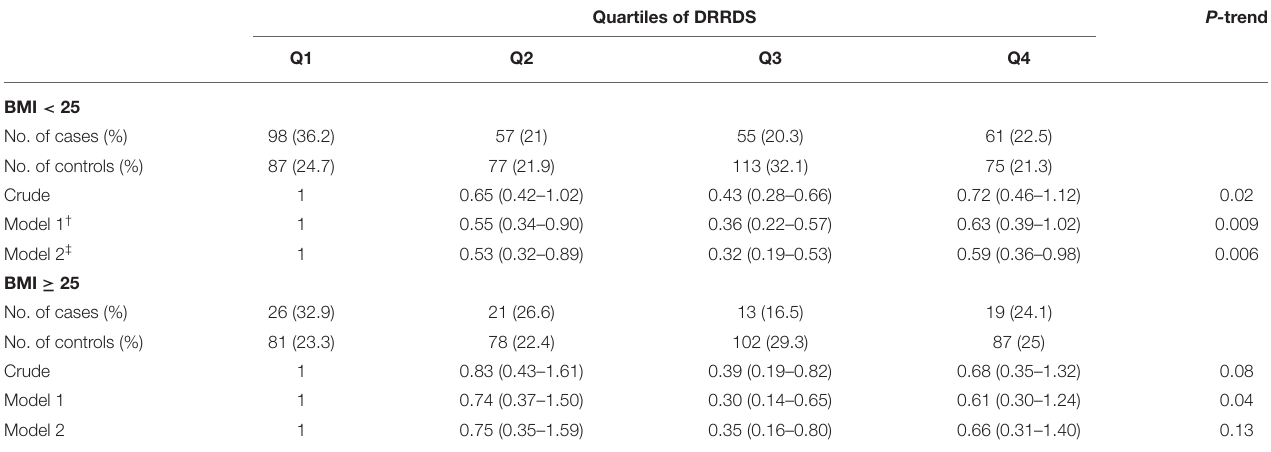
TABLE 5 | Multivariable-adjusted odds ratios (95% CIs) for breast cancer across quartile categories of DRRDS, stratified by